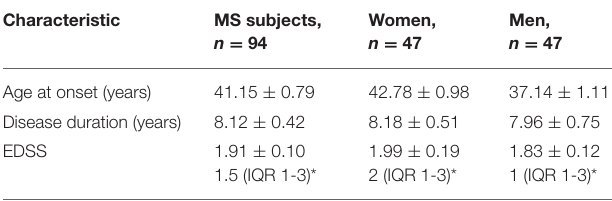
TABLE 1 | The clinical characteristic of the MS subjects’